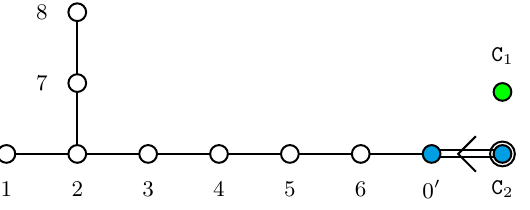
Figure 4 . Generalized Dynkin diagram for d = 2 theories, obtained by replacing the node 0 by 0 0 as shown in